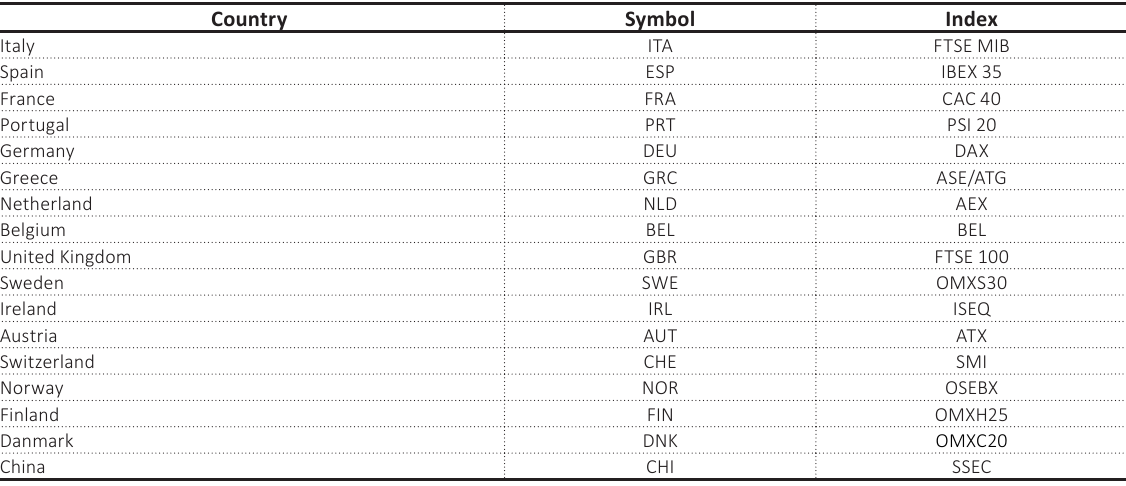
Table A1. Country and indices sample